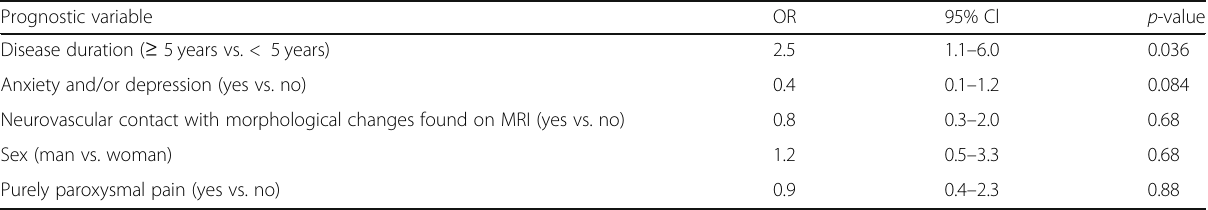
Table 4 Associations between clinical characteristics and good outcome Prognostic variable